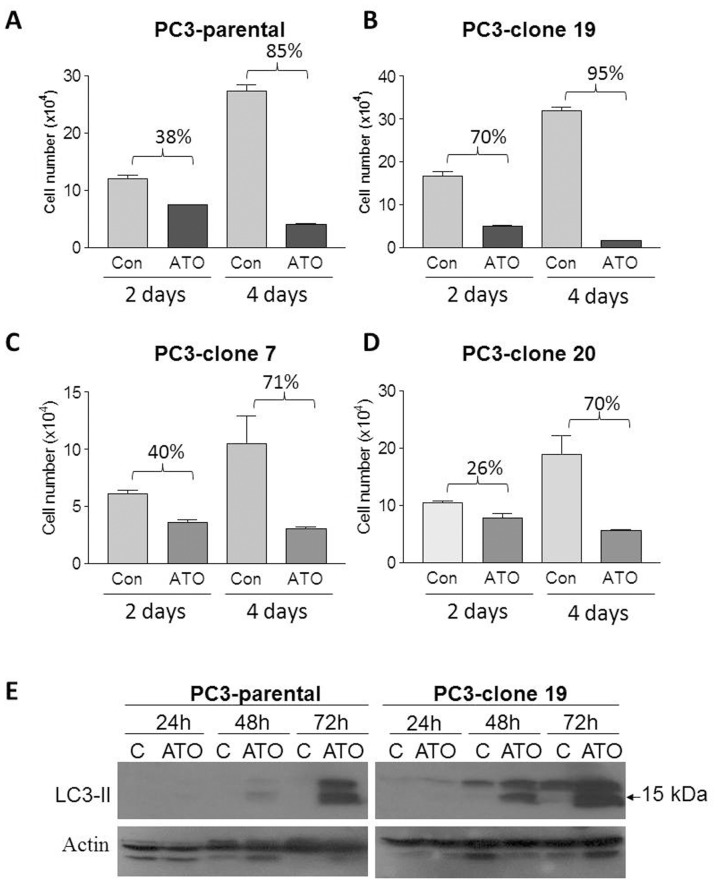
Cellular sensitivity in response to ATO correlates to autophagy induction in PC3 cells.(A–D) PC3 parental (A) and PC3 clone 19 (B), 7(C) and 20 (D) cells were cultured in 6 well plates and treated with 5 µM ATO for 2 or 4 days. Cell numbers are expressed as Mean ± SD, n = 3. (C) PC3 parental and PC3-clone 19 cells were treated with 5 µM ATO side by side with the proliferation assay (A & B) for 24 h, 48 h or 72 h. Cell lysates were collected for western blot analysis of LC3-II expression.